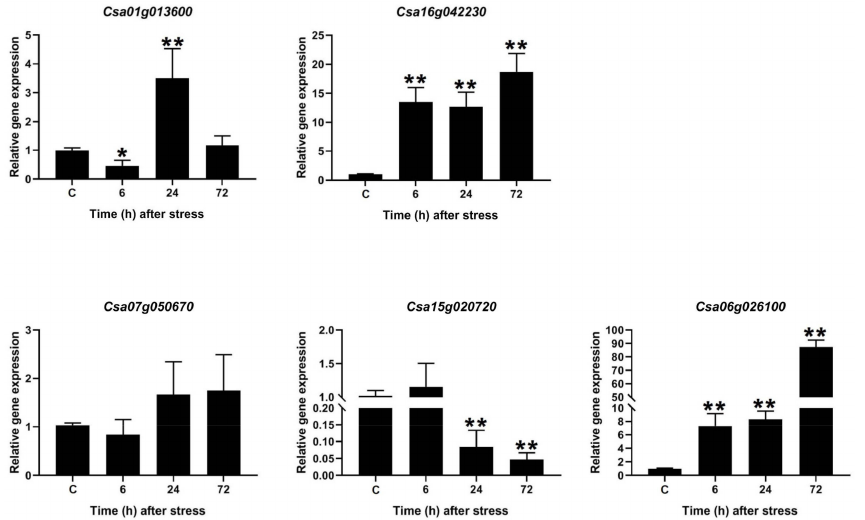
Figure 11. The expression levels of the SULTRs in C. sativa in response to salinity stress (i.e., 200 mM of NaCl) at three timepoints (6, 24, and 72 h after salt stress) and under control conditions (C, i.e., irrigation without NaCl), based on the qPCR data. Note: * and ** indicate significant differences between the expression levels following the salt treatment and those under normal conditions (based on a Student’s t-test) at p < 0.05 and p < 0.01,